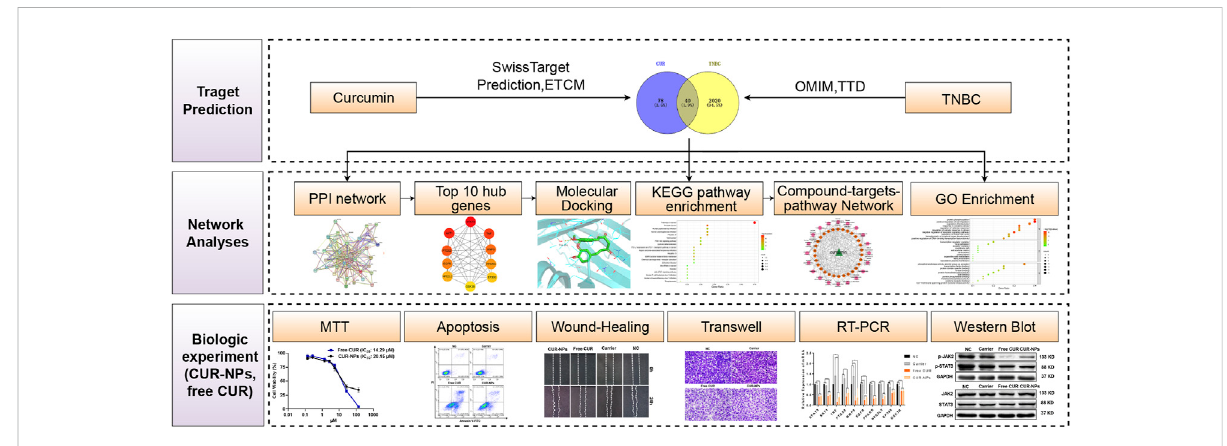
FIGURE 1 The work fl ow of this